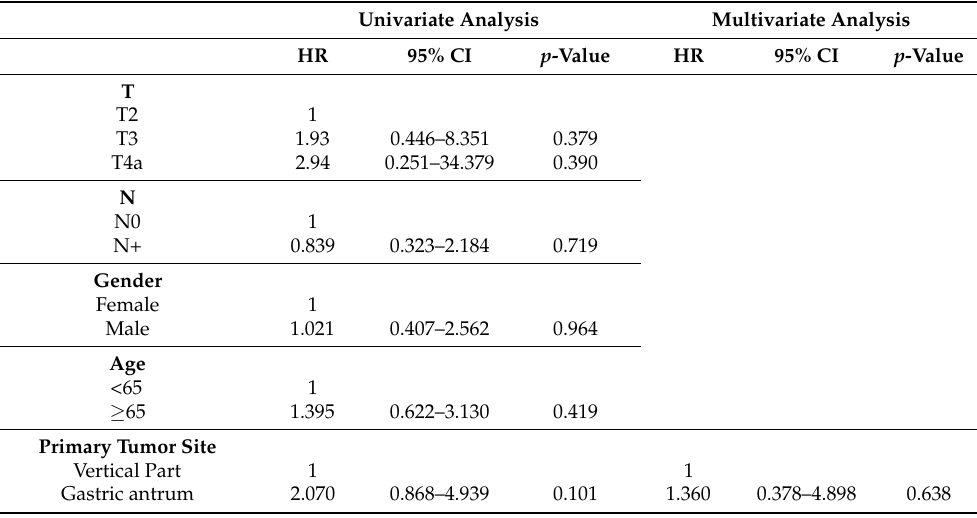
Table 2. Univariate and multivariate analysis of risk factors associated with